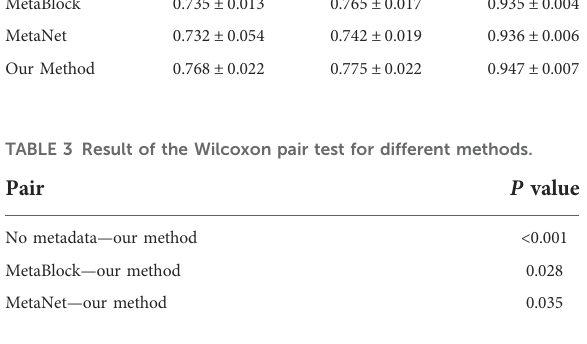
Table 2 . Our proposed method achieved the best performance